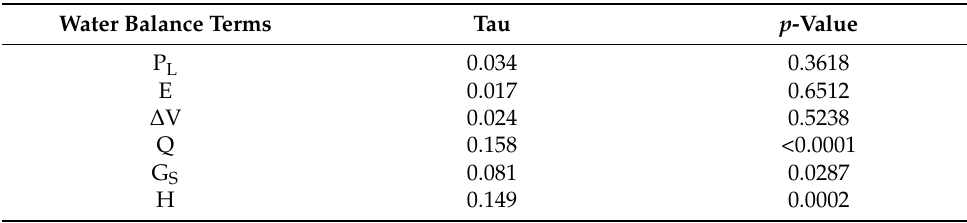
Table 2. Results of Mann–Kendall test applied on the main water balance